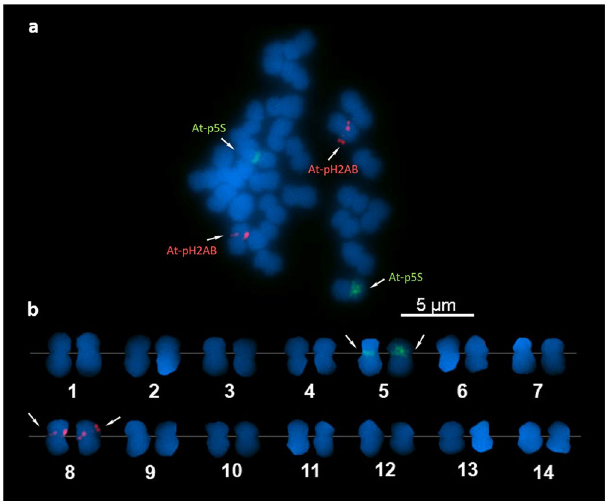
Figure 3. Fluorescence in situ hybridization image showing hybridization signals of the At-p5S probe labeled with digoxigenin-dUTP (green) and At-pH2AB probe labeled with Cy3-dUTP (red) in Acropora pruinosa chromosomes ( a ). Karyogram based on decreasing chromosome lengths ( b ).